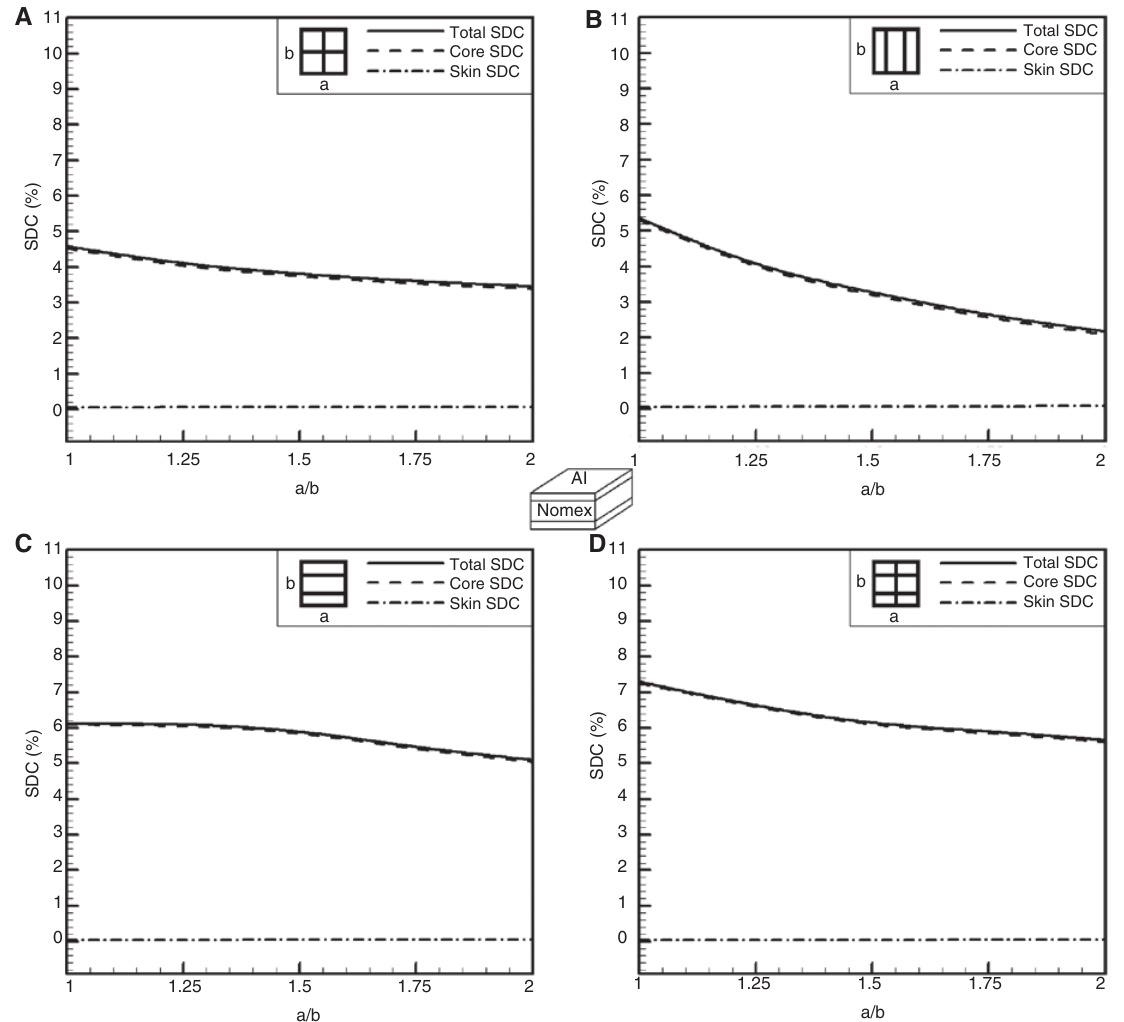
Figure 10: Damping of an all-free, Al/Nomex honeycomb sandwich panel versus aspect ratio, in various modes. (A) First mode, (B) second mode, (C) third mode, (D) fourth